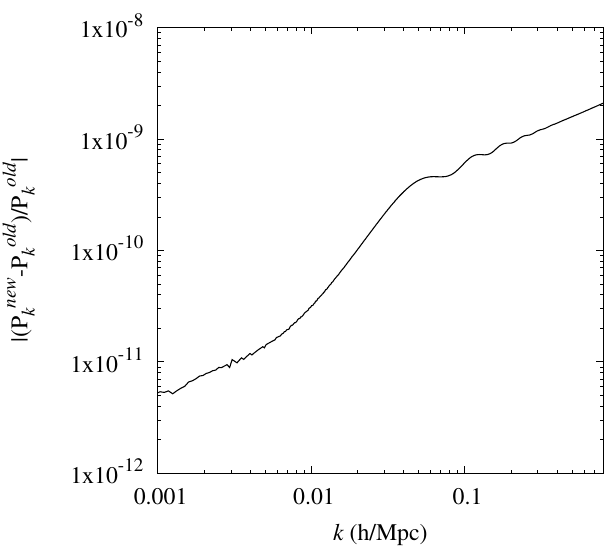
Figure 4. Relative difference in the matter power spectrum at z = 1000. We fixed the same background parameters for both codes, so that the error only depends on the difference in the equations of motion for the baryon-photon sector.